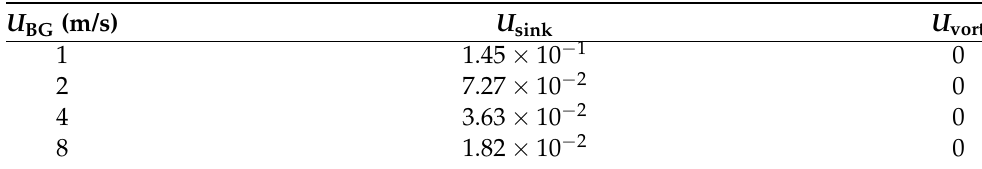
Table 1. Parameters used for the head-fire simulations.